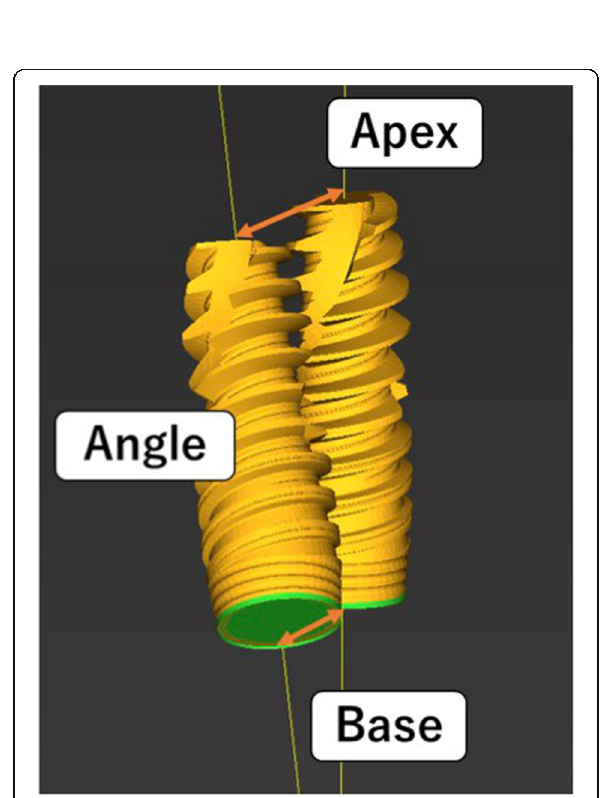
Fig. 2 Measurement outcomes. Angle (°): angle between the long axes of the implant model. Base (mm): distance between the platform centers of the implant model. Apex (mm): distance between the implant model